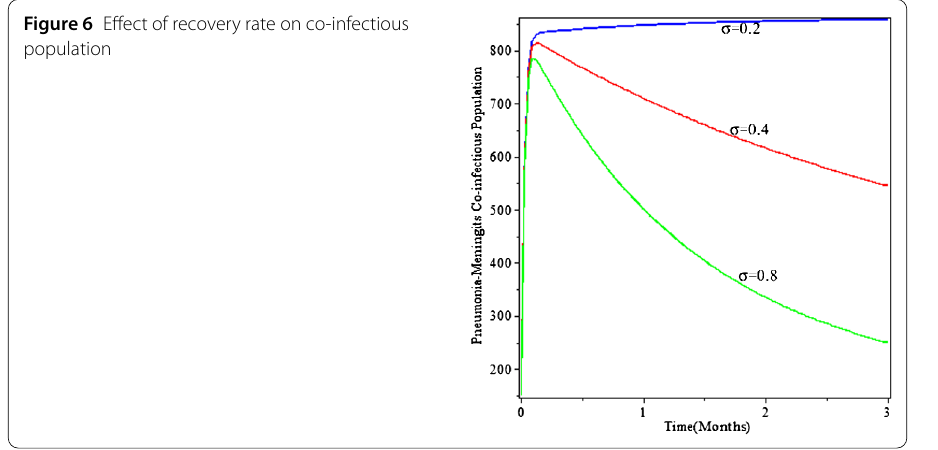
Figure 6 Effect of recovery rate on co-infectious